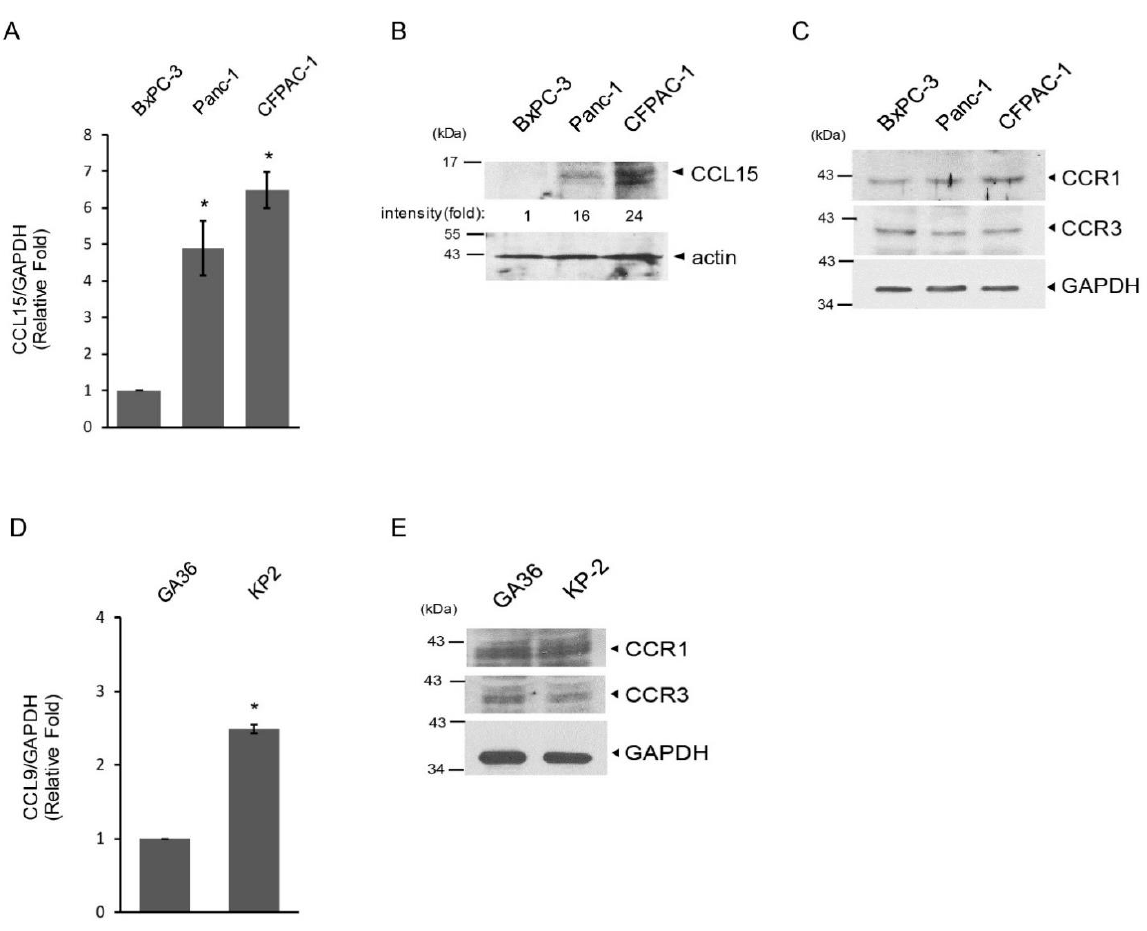
Figure 2. Upregulation of CCL15 levels in metastatic PDAC cells. ( A ) Levels of CCL15 mRNA in human PDAC cell lines (BxPC-3: non-metastatic; Panc-1 and CFPAC-1: metastatic) were assessed by real-time qRT-PCR. Levels of GAPDH were used as an internal control. *: p < 0.05 as compared to BxPC-3. ( B ) Levels of CCL15 protein expression in human PDAC cell lines were examined by immunoblots. Levels of actin protein were used as a loading control. ( C ) Protein levels of CCR1 and CCR3 in human PDAC cell lines were evaluated by immunoblots. GAPDH protein levels were used as a loading control. ( D ) mRNA levels of CCL9, the orthologue of CCL15 in murine PDAC cells KP2 and pancreatic ductal cells GA36 were assessed by real-time qRT-PCR. Levels of GAPDH mRNA were used as an internal control. *: p < 0.05 as compared to GA36. ( E ) Levels of CCR1 and CCR3 expression in murine GA36 and KP2 cells were determined by immunoblots. GAPDH protein levels were used as a loading control. Original blots see supplementary File S1.